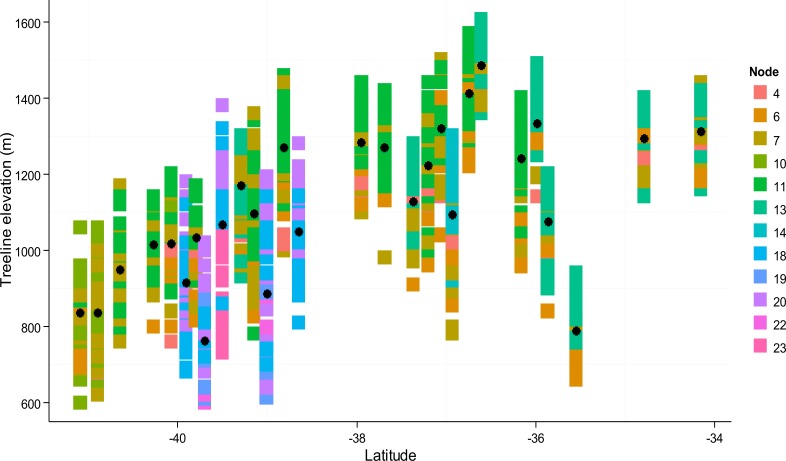
Tile graph of the distribution of terminal nodes from the conditional inference tree for all sampled treeline locations by site latitude and elevation.The terminal inference tree nodes represent discrete recursive partitioning pathways in the conditional inference tree (see Fig. 6). Black points represent the mean treeline elevation at each study area.